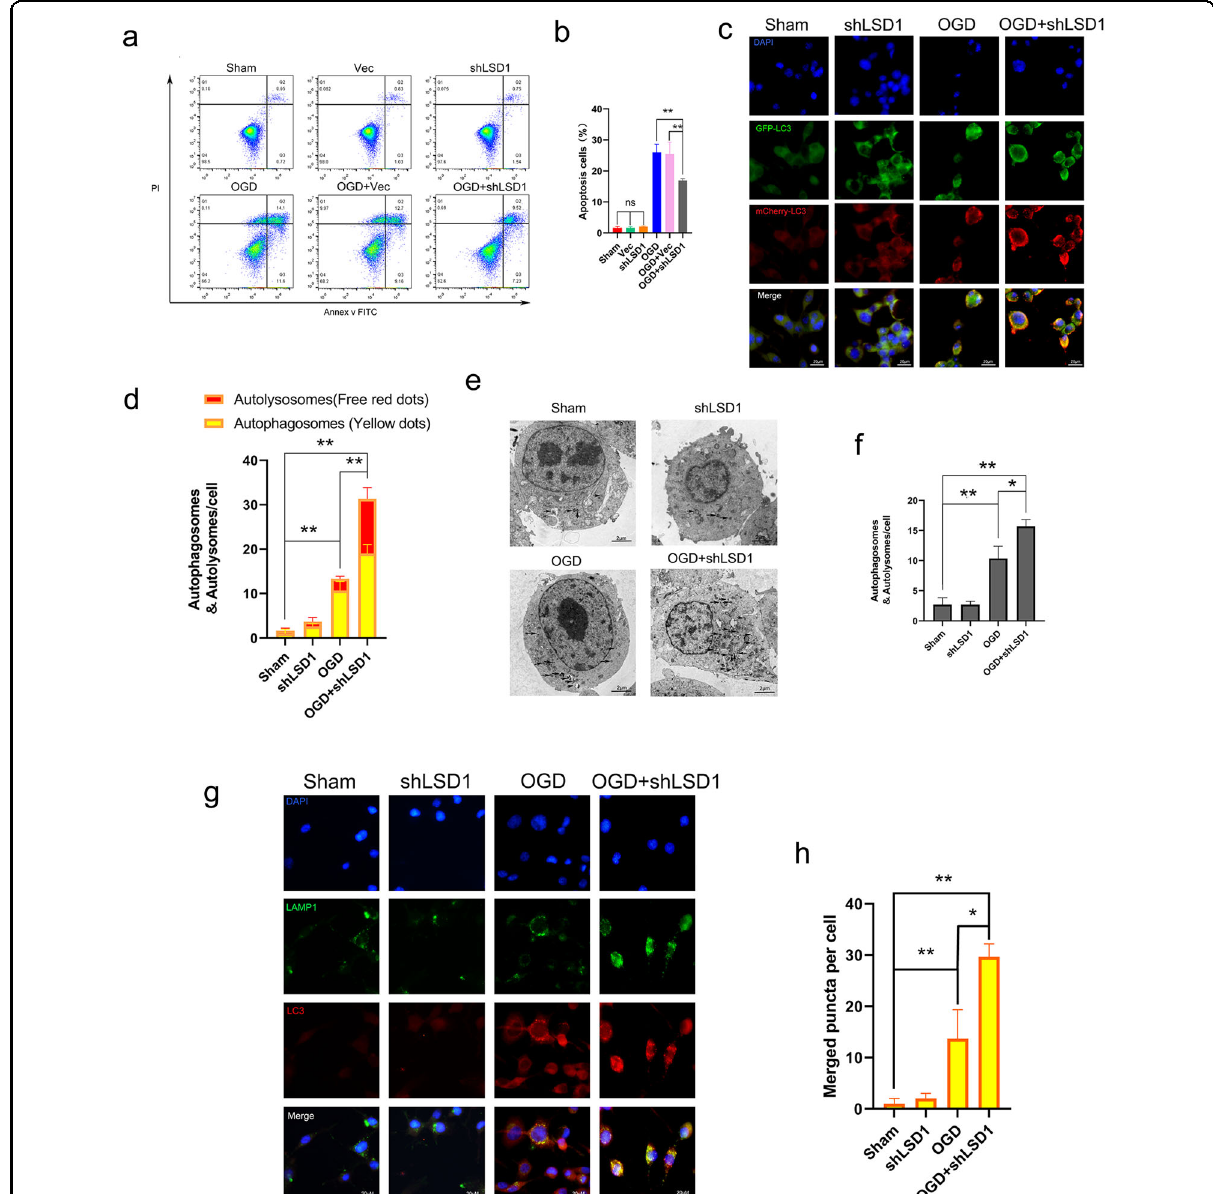
Fig. 5 Knockdown of LSD1 upgraded autophagy and downgraded apoptosis in vitro. a Annexin V/FITC/PI double staining and fl ow cytometry detected OGD-induced PC12 apoptosis including or not including LSD1 knockdown. b Quantitative results for apoptotic PC12 cells with LSD1 knockdown treatment or lack of treatment. c , d High magni fi cation fl uorescence microscope image of the autophagic fl ux of mCherry-GFP-LC3 transfected PC12 cells. Autophagosomes were labeled with red and green fl uorescence (yellow dots); autophagic lysosomes were labeled with red fl uorescence (red dots). The OGD + shLSD1 group had more of these dots compared to the OGD group. Scale bar = 20 μ m. e , f Transmission electron microscopy of autophagosomes of PC12 cells. Sample images indicate usual autophagosomes and autolysomes inside shLSD1-treated OGD PC12 cells. g , h Immuno fl uorescent image showing double-labeling with LC3B (an autophagic biomarker, red puncta) and LAMP1 (a lysosomal biomarker, green puncta). The OGD + shLSD1 group had more of merged puncta (yellow puncta) compared to the OGD group. Scale bar = 2 μ m. One-way ANOVA and Tukey ’ s multiple comparisons test was used to compute p values for mean ± SD of three independent experiments. * p < 0.05; ** p <